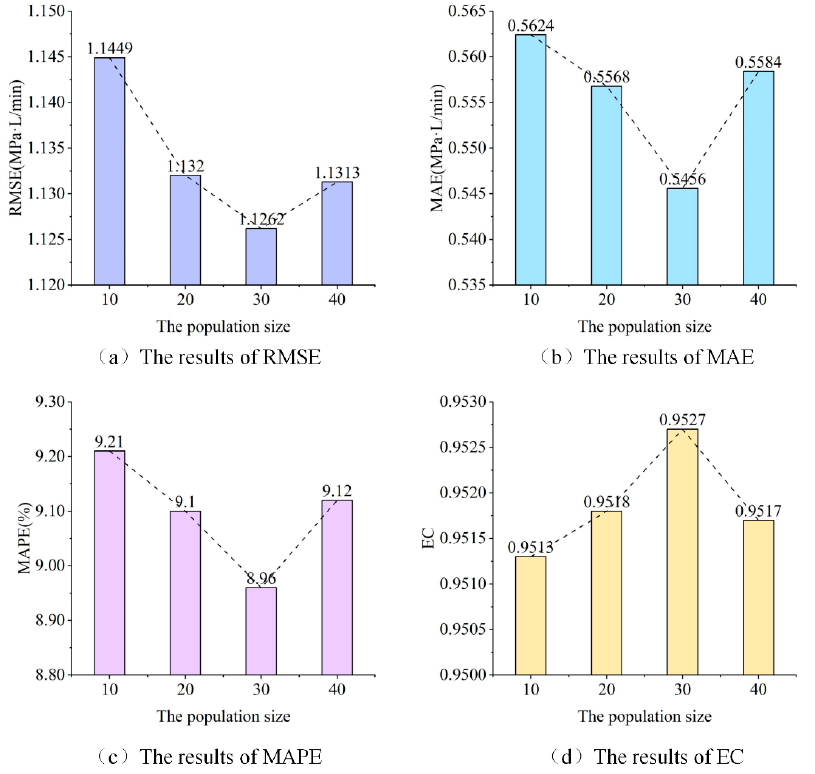
Figure 8. Selection of statistical population size of IJaya algorithm.